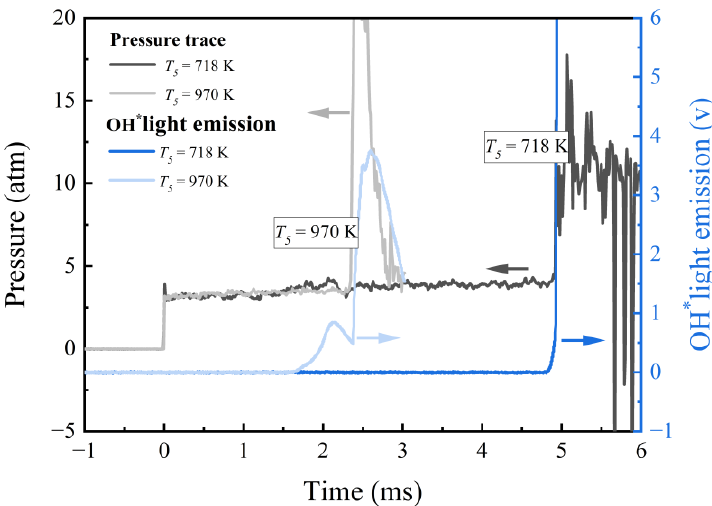
Figure 5. Typical time histories of reflected shock pressure and OH* chemiluminescence in the ignition process of PHI2.0 DME/‘air’ mixture with and without pre-ignition at 3 atm.